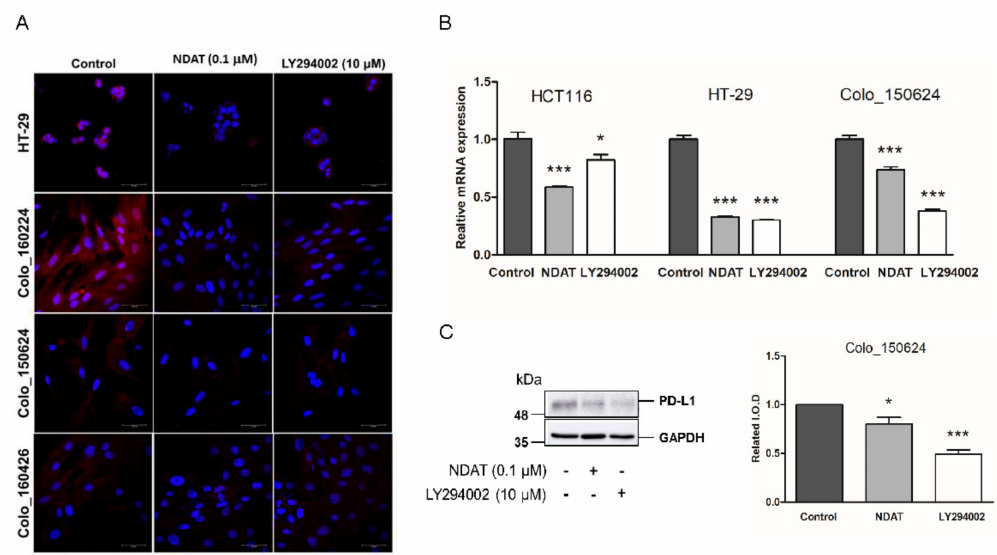
Figure3. NDATandLY294002inhibitPD-L1accumulationinCRC.HT-29cells(colorectalcancercellline) and three established primary human CRC cell cultures (Colo_160224, Colo_150624, and Colo_160426) were treated with NDAT or LY294002 for 24 h. ( A ) Immunocytochemistry was performed for PD-L1 (red) and the nucleus was counterstained with DAPI (blue). Scale bar = 50 µ m. ( B ) Gene